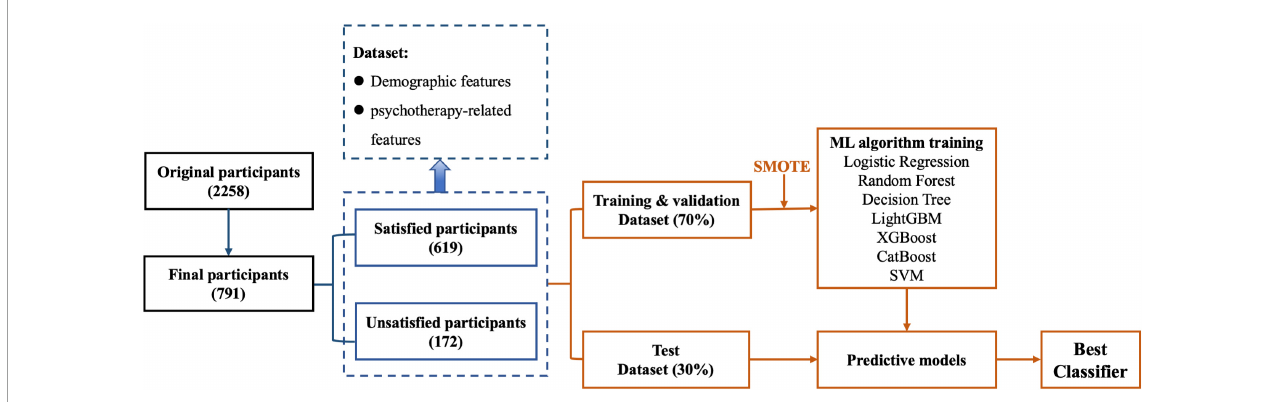
FIGURE1 The flowchart of data processing and machine learning-based modeling. The raw dataset was processed by removing non-compliant data entries to form the dataset used in the study. The dataset consisted of participants’ demographic features, and psychotherapy-related features were split into a training and validation dataset and a test dataset. Different machine learning algorithms were selected for training based on the training and validation dataset. Predictive models were obtained after parameter tuning. The final classifier was determined according to the comparison of each trained model’s prediction performance using the test